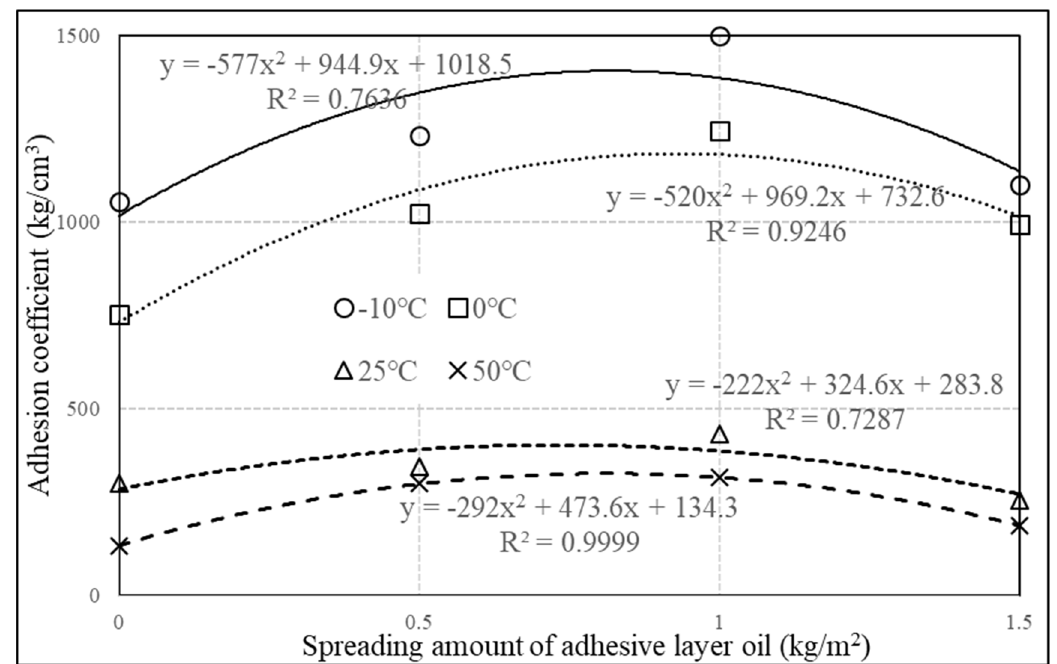
Figure 18. The K max curves of AC-25/ cement-stabilized base. Table 12. Optimum spreading amount of transparent layer of oil. Temperature Transparent Layer of Oil A − 10 ◦ C y = − 577x 2 + 944.9x + 1018.5 0.82 kg/m 2 0 ◦ C y = − 520x 2 + 969.2x + 732.6 0.93 kg/m 2 25 ◦ C y = − 222x 2 + 324.6x + 283.8 0.73 kg/m 2 50 ◦ C y = − 292x 2 + 473.6x + 134.3 0.81 kg/m